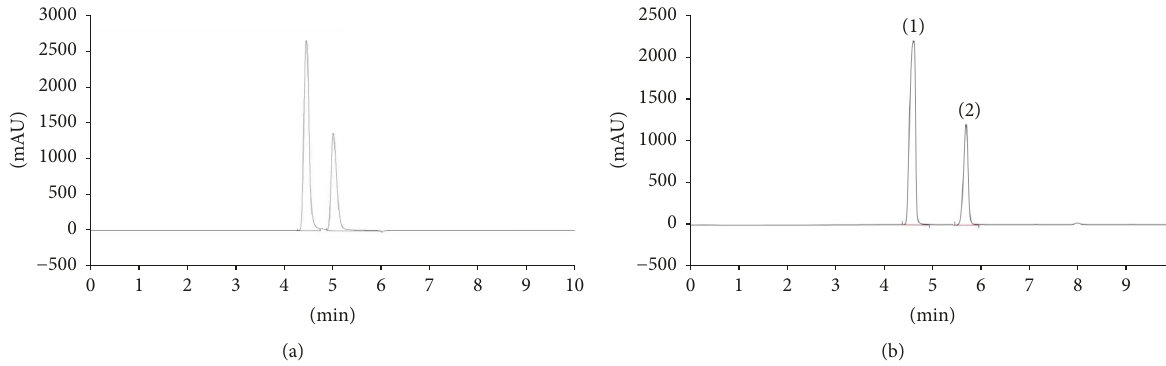
Figure 4: Comparative chromatograms showing isocratic RP-HPLC separation of mixed standard, L-citrulline, and L-arginine from 2 different columns: (a) Zorbax Eclipse XDB-C 18 , 5 𝜇 m, and (b) Gemini C 18 , 3 𝜇 m; efficient separation and the best resolution were achieved by the Gemini C 18 column which showed that compounds are well separated. The peaks marked represent (1) L-arginine and (2)